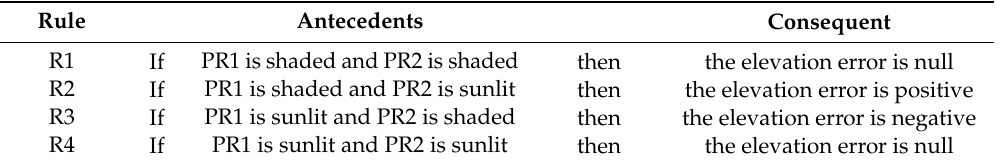
Table 1. Action rules for the elevation error (PR1 and PR2).